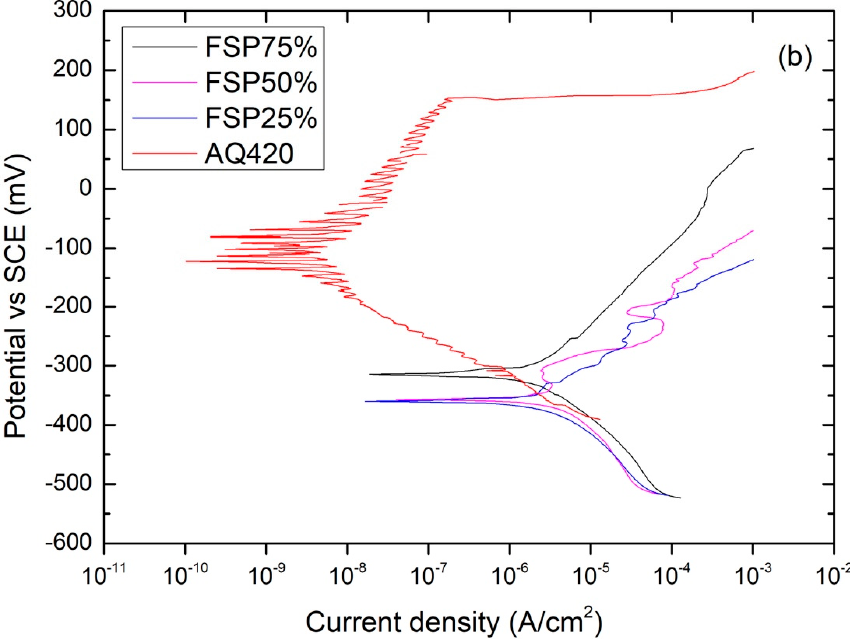
Figure 10. Potentiodynamic polarization curves of ( a ) as-received 420, as-quenched 420, and FSP250 [18]; ( b ) FSP75%, FSP50%, FSP25%, and AQ420 in 3.5% NaCl solution at 25 °C.